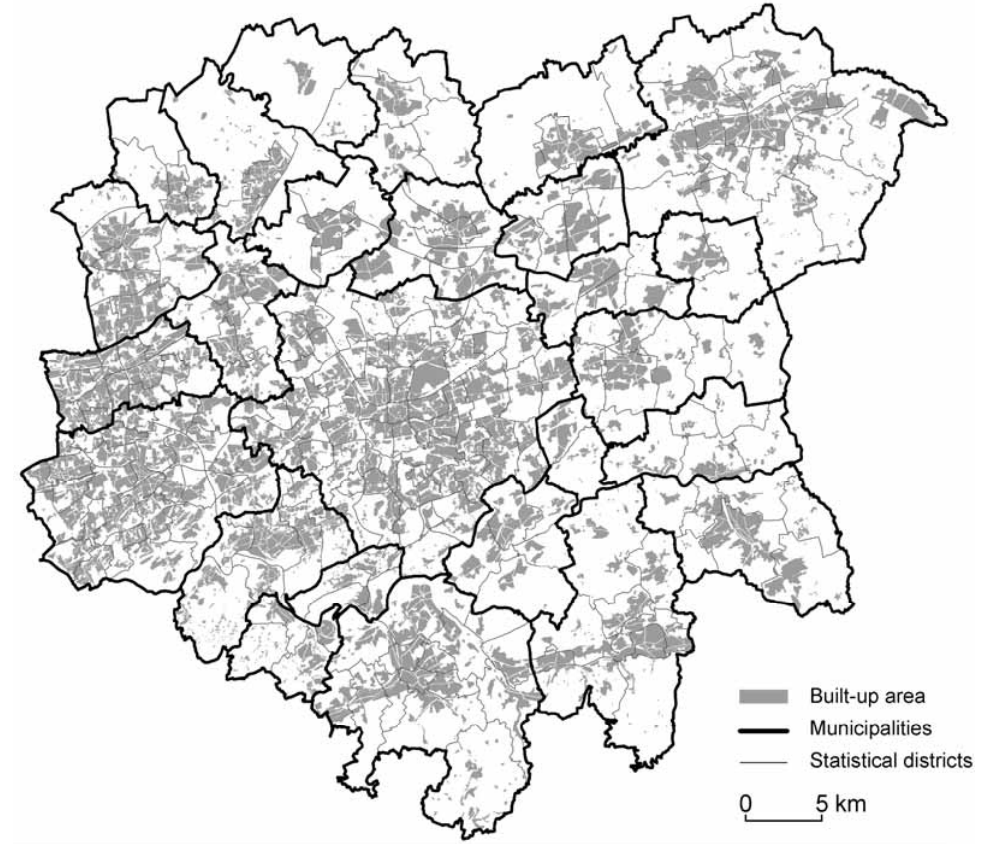
Figure 3. The Dortmund case study